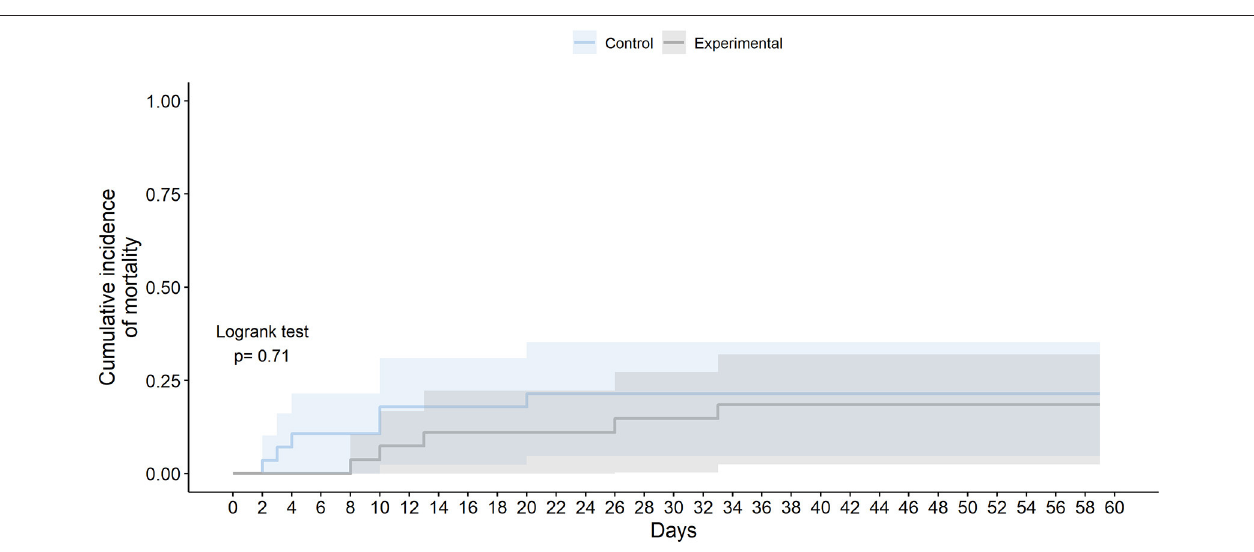
FIGURE 3 | All cause mortality in the ITT